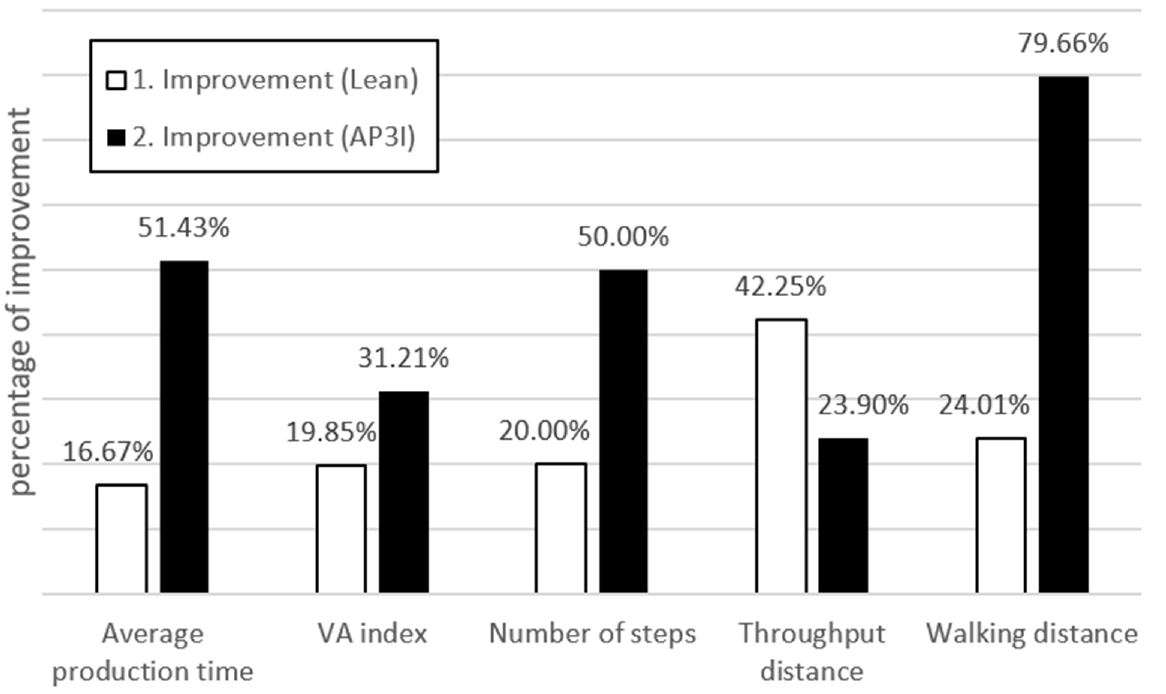
Figure 9. Comparison of relative improvement rates of process indicators—packing process.